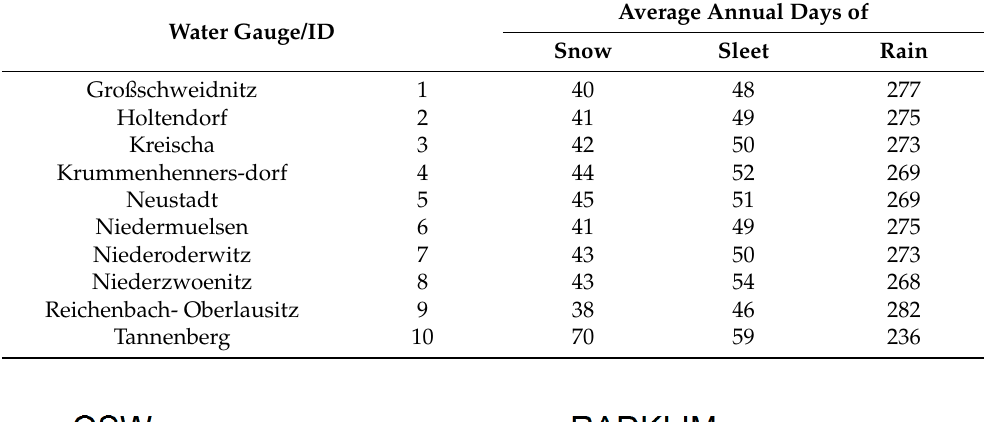
Table 2. Average days for each type of precipitation classified with mean temperature (Appendix C) for the ten selected catchments in the period 2001–2017.